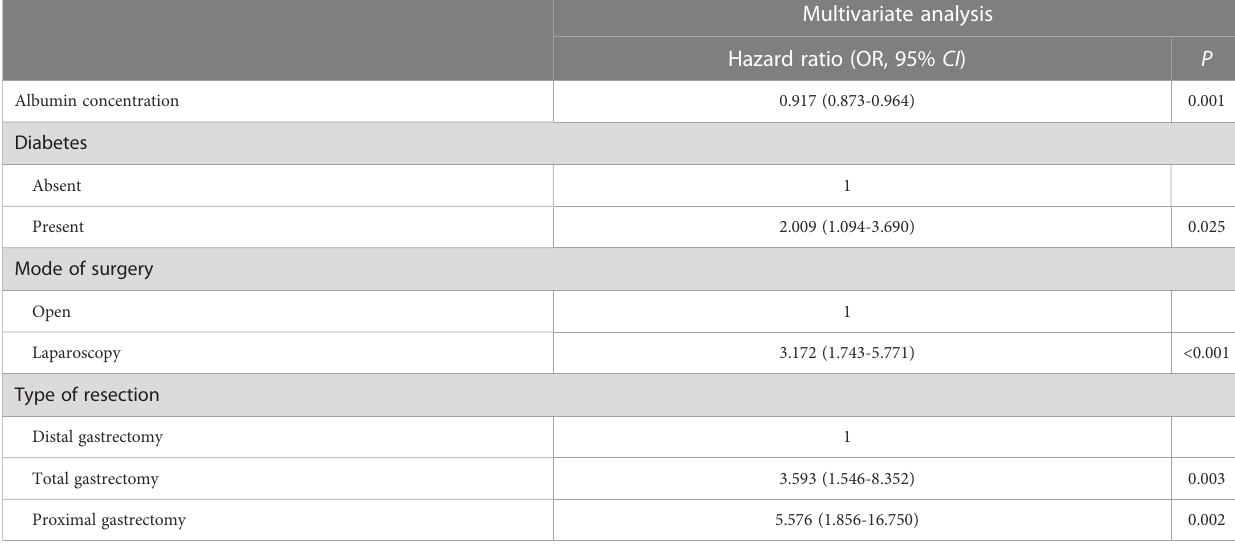
TABLE 5 Multivariate analysis to identify clinicopathological and operative variables that are associated with anastomotic leakage.